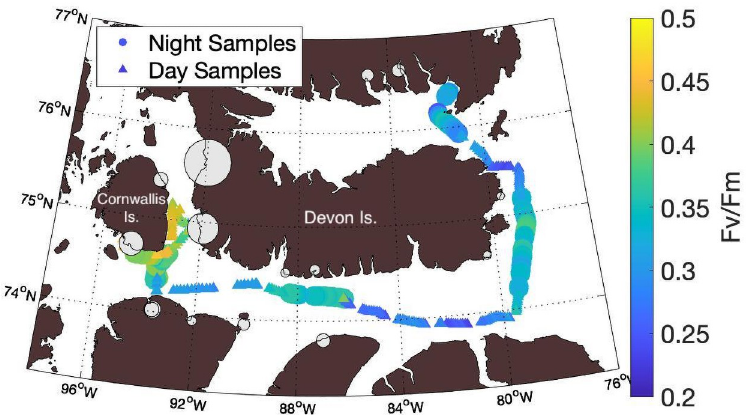
Fig 9. Spatial distribution of riverine nutrient inputs and photochemical efficiency (F v /F m ) along the ship track. River contributions of nitrate and nitrite are indicated by the size of grey bubbles. The largest inputs of nitrate and nitrite in the region are concentrated in the strait between Cornwallis and Devon Islands, coincident with observations of raised F / F values. Larger circles are used to denote night-time measurements of F v m denote day-time measurements.